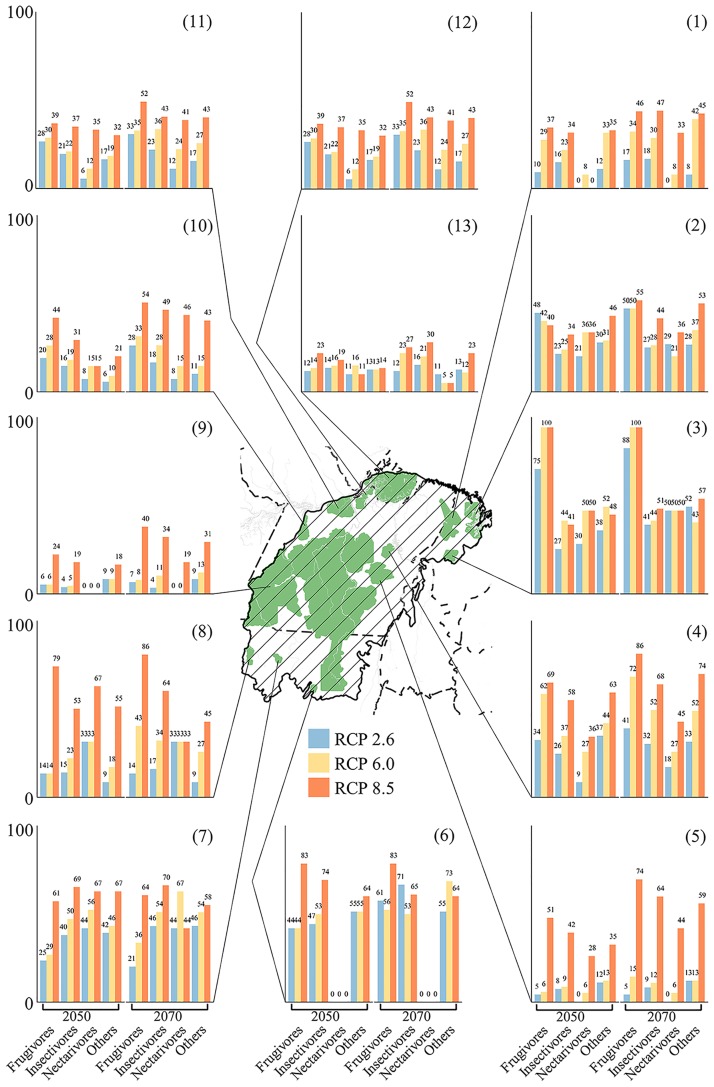
Percentage of species predicted to disappear in each protected area (PA).Each bar plot represents the percentage of species loss in relation to current projected species richness and assuming no species turnover. The central map and numbers therein indicate the PA names: (1) Gurupi Mosaic; (2) APA Baixada Maranhense; (3) IL Guajajara; (4) IL Parakana; (5) Carajás Mosaic; (6) ESEC Rio Ronuro; (7) IL Kayabi; (8) IL Erikbakts; (9) Terra do Meio Mosaic; (10) FLONA Tapajós; (11) RESEX Renascer and Verde para sempre; (12) RESEX Gurupá-Melgaço and FLONA Caxiuanã; (13) Marajó Mosaic. For more details see S2 and S4 Tables.